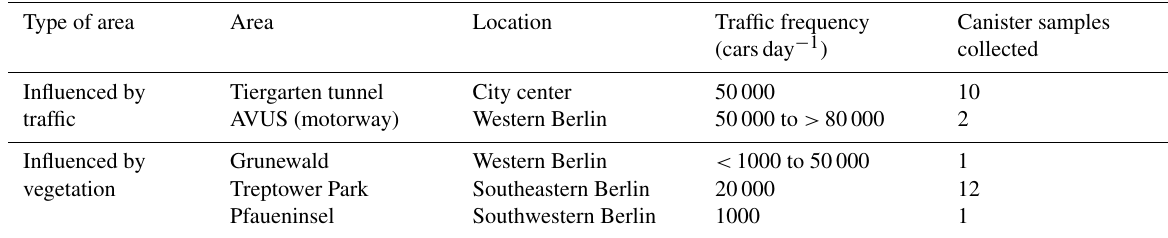
Canister samples (carsday − 1 ) collected